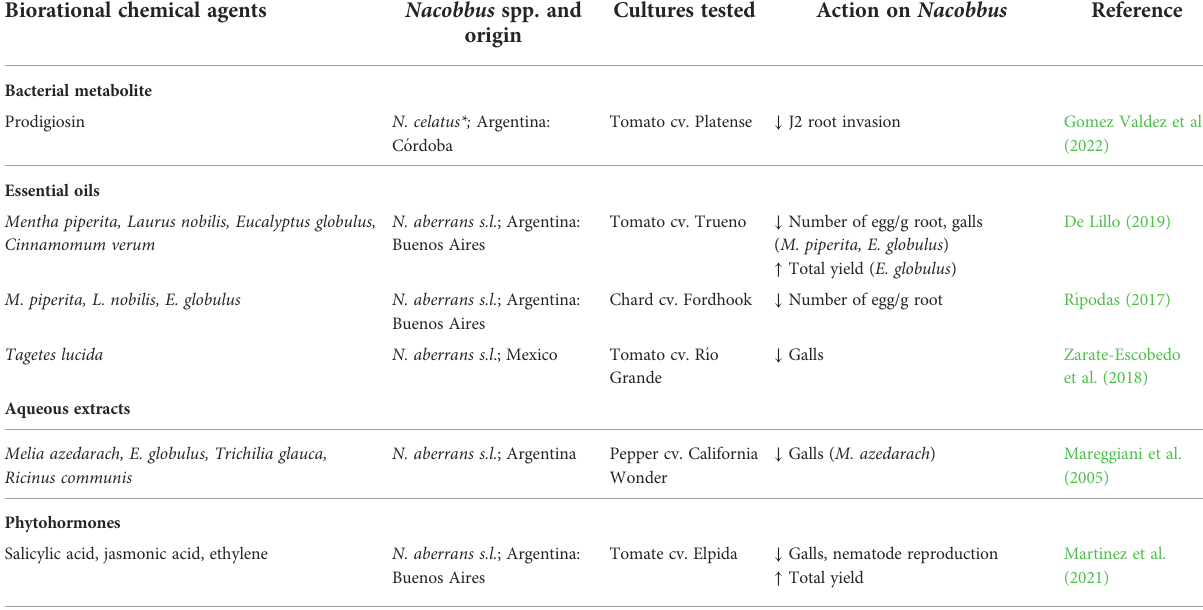
TABLE 3 Response of Nacobbus spp. to the interaction with different biorational products (metabolites, essential oils, extracts, phytohormones) in in vivo experiments. Biorational chemical